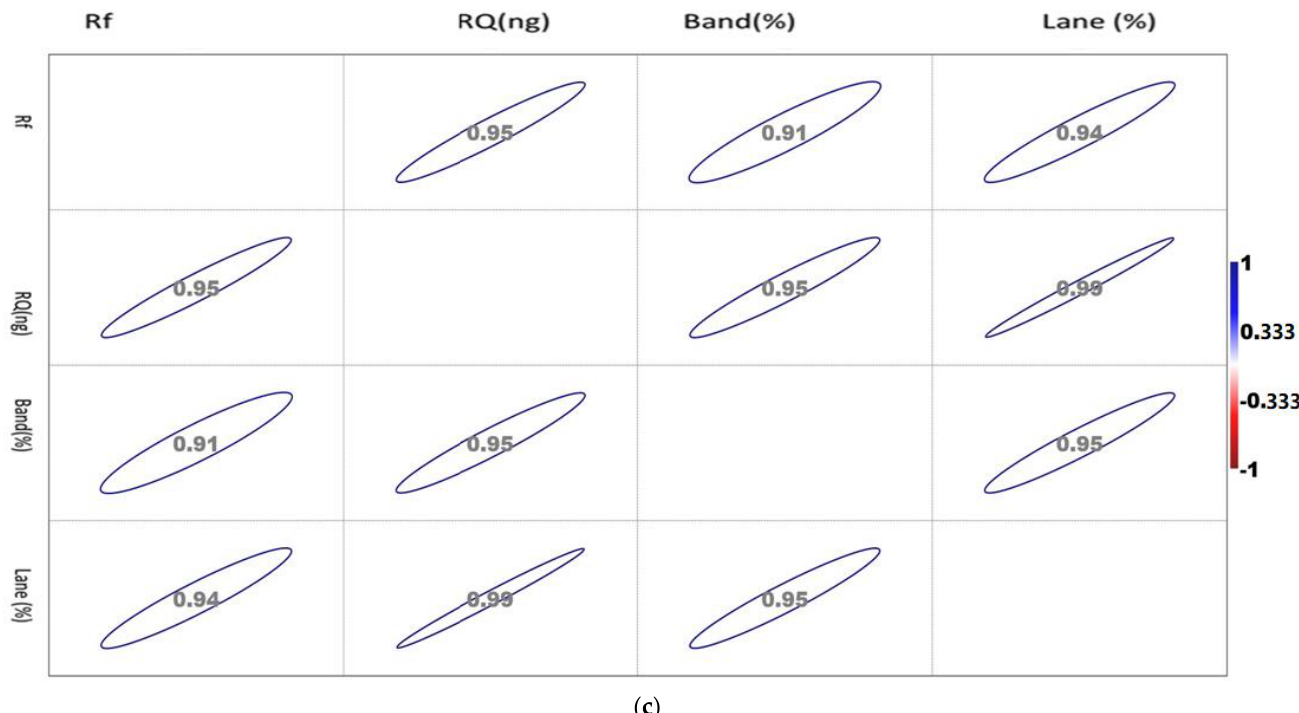
Figure 2. ( a ). Showing the correlation between the densiometric parameters of the Mx gene. ( b ). Showing the correlation between the densiometric parameters of the ISG15 gene. ( c ). Showing the correlation between the densiometric parameters of the STAT1 gene.